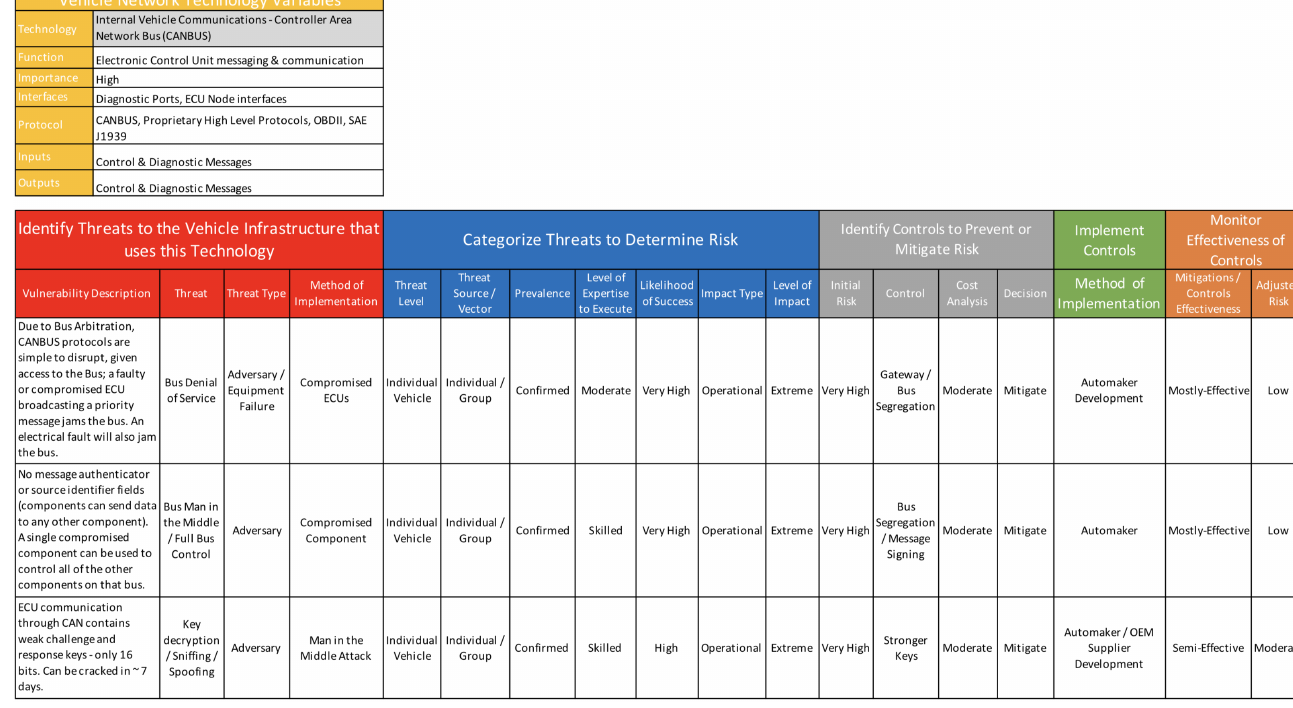
Figure A3. Vehicular Network Risk Management Process Example for Internal Vehicle Communications—Controller Area Network Bus